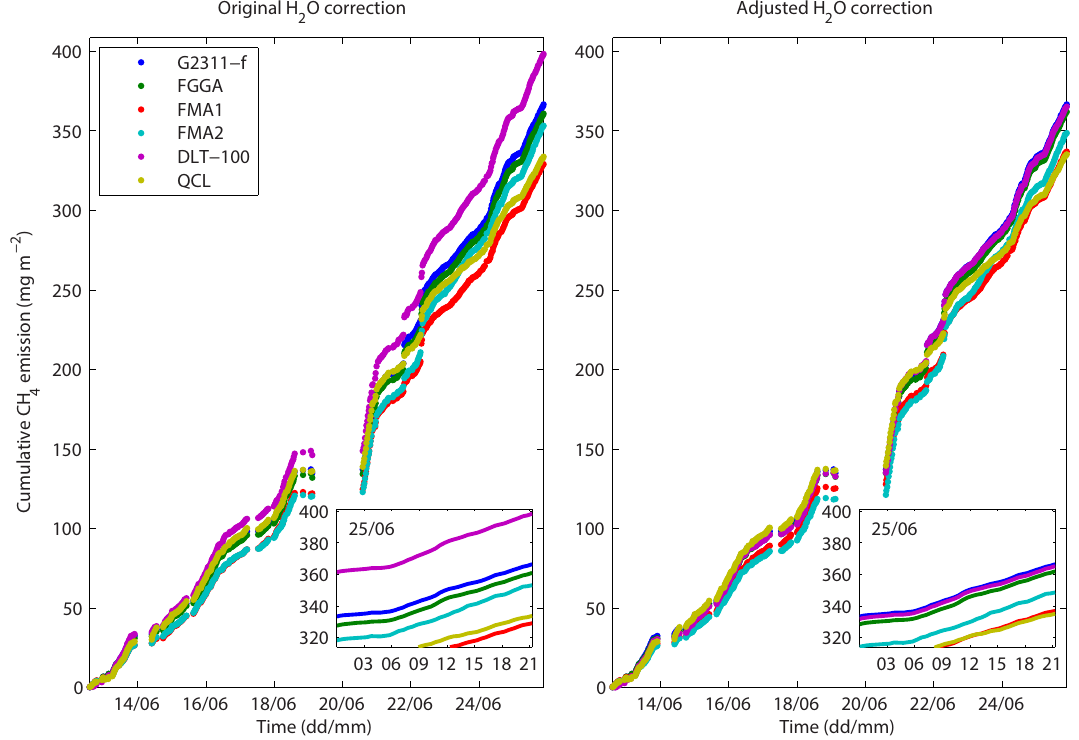
Figure 13. Cumulative sums of CH 4 fluxes during a part of the campaign (from 12 to 25 June). The time series are not gap filled and they all contain the same number of points. The left plot shows fluxes calculated with the original H 2 O corrections and the right plot shows cumulative CH 4 fluxes after adjusting the H 2 O corrections with the slopes given in the right in Table 4, in other words by adding − kF WPL where k is the slope. Thus, after this adjustment the differences between G2311-f CH 4 fluxes and other CH 4 fluxes do not depend on F WPL Data from LI-7700 and G1301-f are not shown. The insets show a close-up of the last